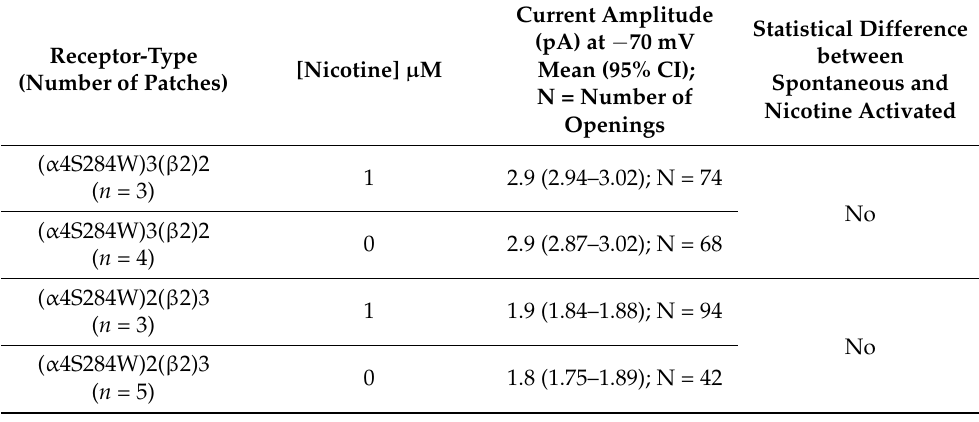
Table 4. Effect of α 4Ser284Trp on amplitudes of spontaneous and Nicotine activated channel